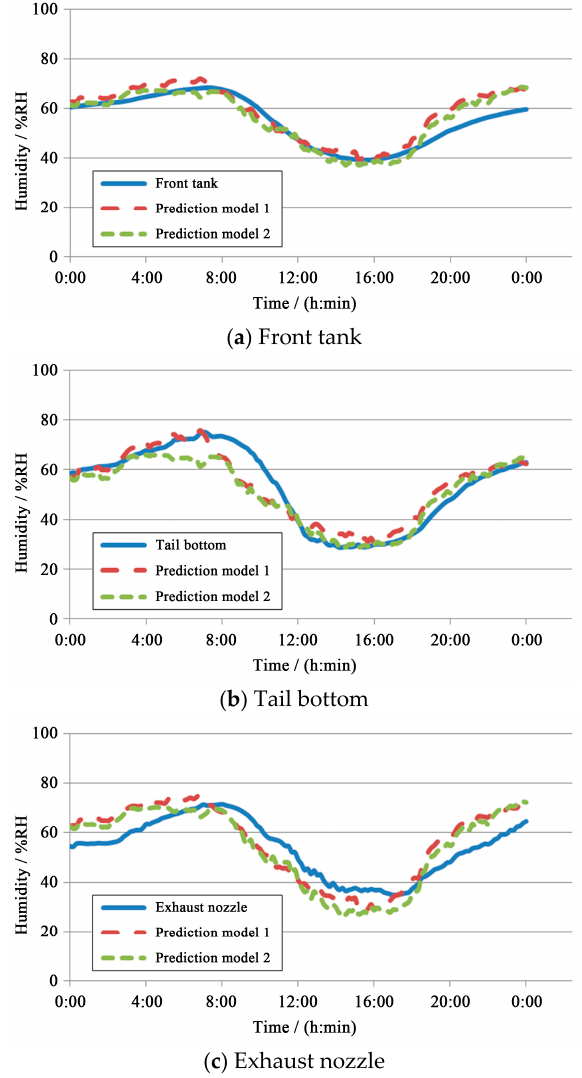
Figure 4. Comparison of measured and predicted humidity values.